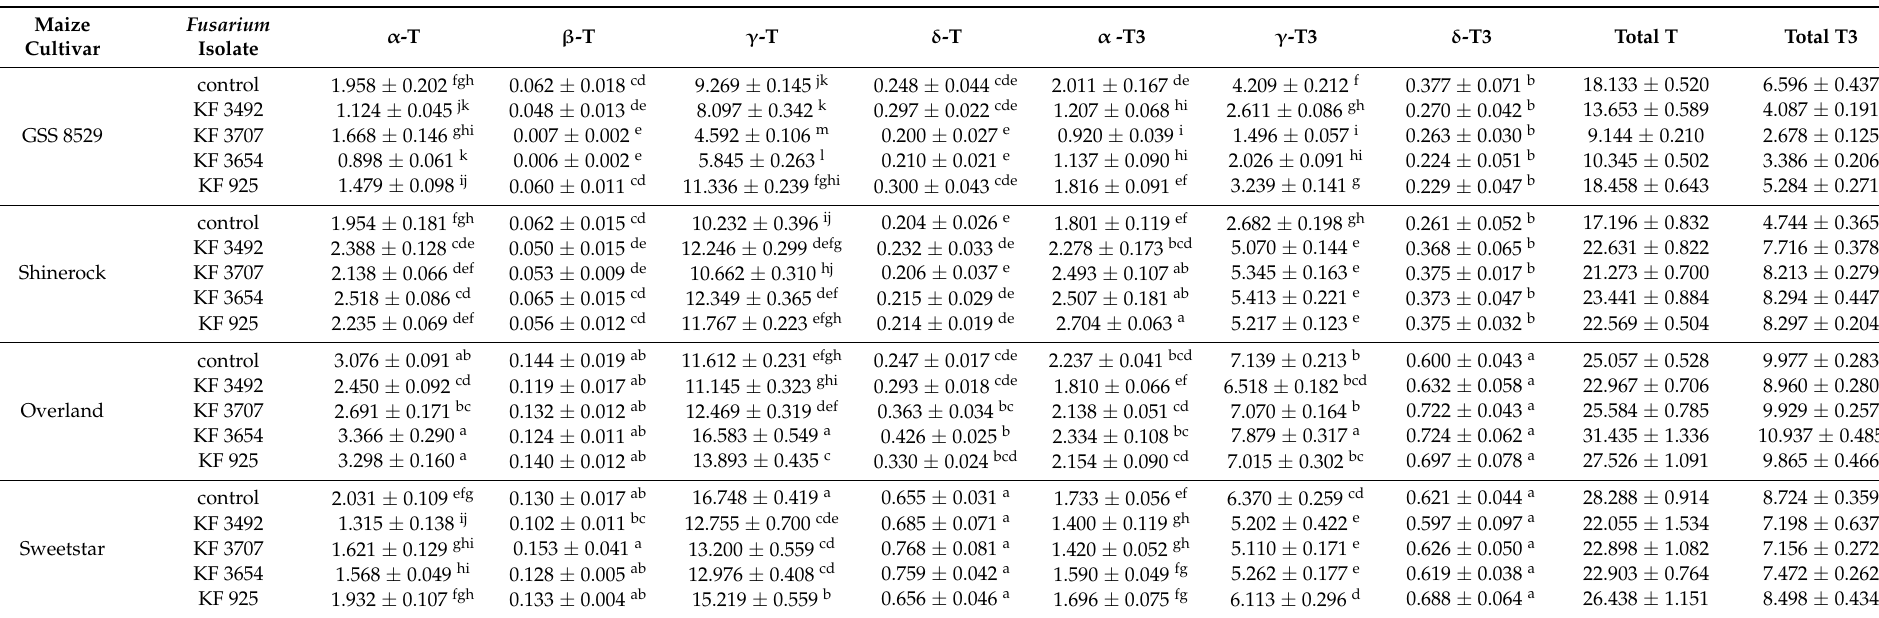
Table 2. Tocopherols and tocotrienols content [mg/100 g of sample] in different maize cultivars inoculated with Fusarium